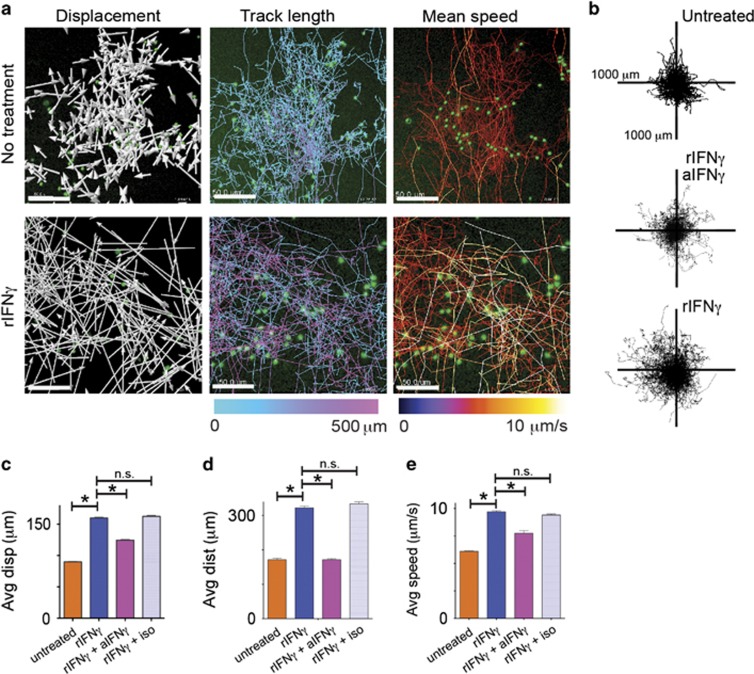
Exogenous IFNγ promotes CD8 T-cell motility and enhances cytotoxicity. (a) Co-cultures of EGFP+OT-I CTL and SIINFEKL-loaded or untreated KC were imaged for 30 h by fluorescence time-lapse microscopy. Recombinant IFNγ was added at time 0. Representative images of tracks created by CTL as they traveled among KC targets have been mapped by software. Vector displacement of the tracks is shown by white arrows. Length of the traveled tracks and mean speed of travel is indicated by the colored legend bars (scale bars, 50 μm). (b) Translated travel tracks from (a) have been plotted from origin showing the distance and spread of the path traveled by the cells within the field of view. Each plot shows the result for one typical experiment of three independent experiments. (c–e) Displacement (c), distance traveled (d) and speed (e) of CD8 T cells in co-culture with antigen-loaded target KC. Average values of four movies are shown (>400 cells). Error bars are S.E.M. (*P<0.05, n.s. not significant)